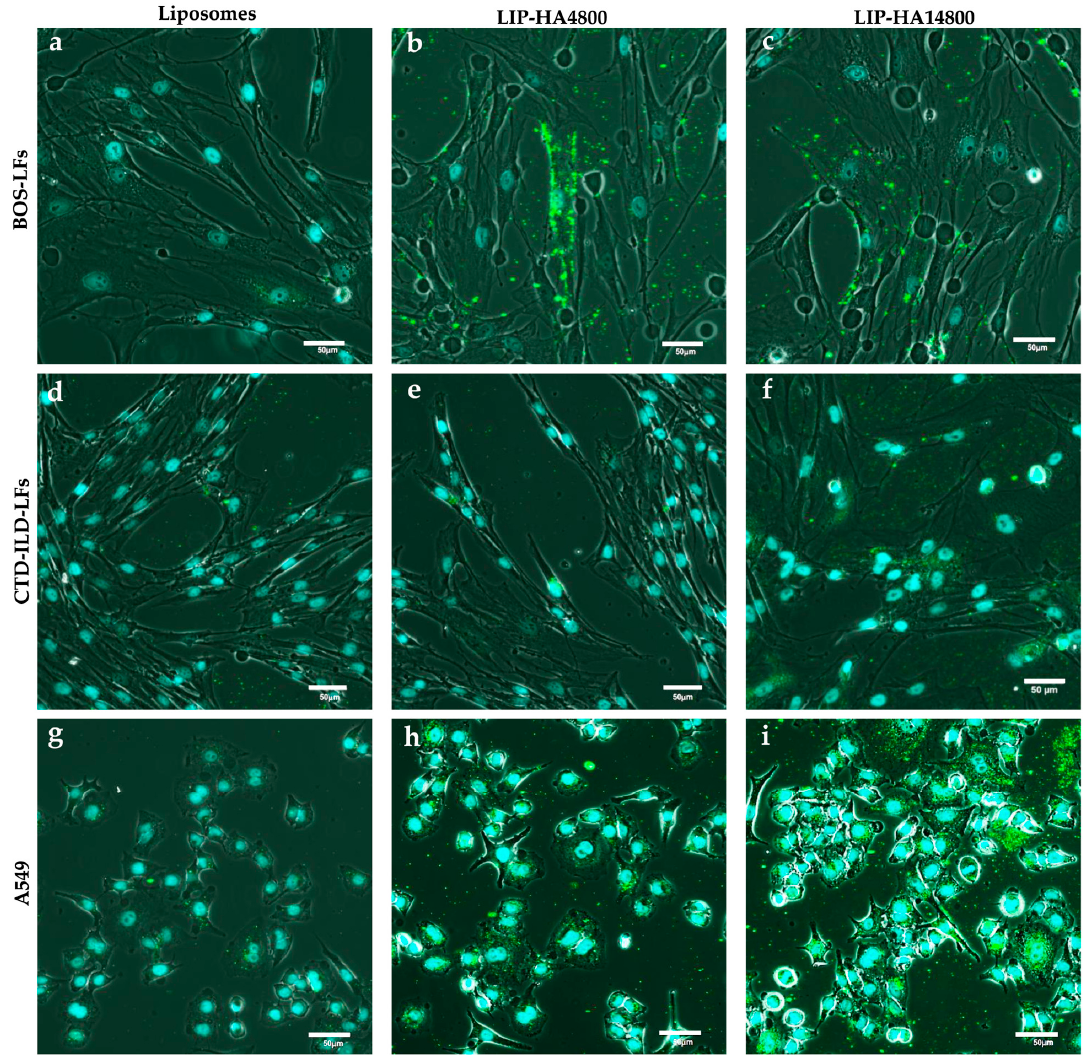
Figure 1. Confocal images of fluorescently labeled LIP ( a,d,g ), LIP-HA4800 ( b,e,h ) and LIP-HA14800 ( c,f,i ) and incubated with BOS-LFs ( a – c ), CTD-ILD-LFs ( d – f ) and A549 ( g – i ). Nuclei of cells = light blue (DAPI); liposomes = green signals. Scale bar = 50 μ m.